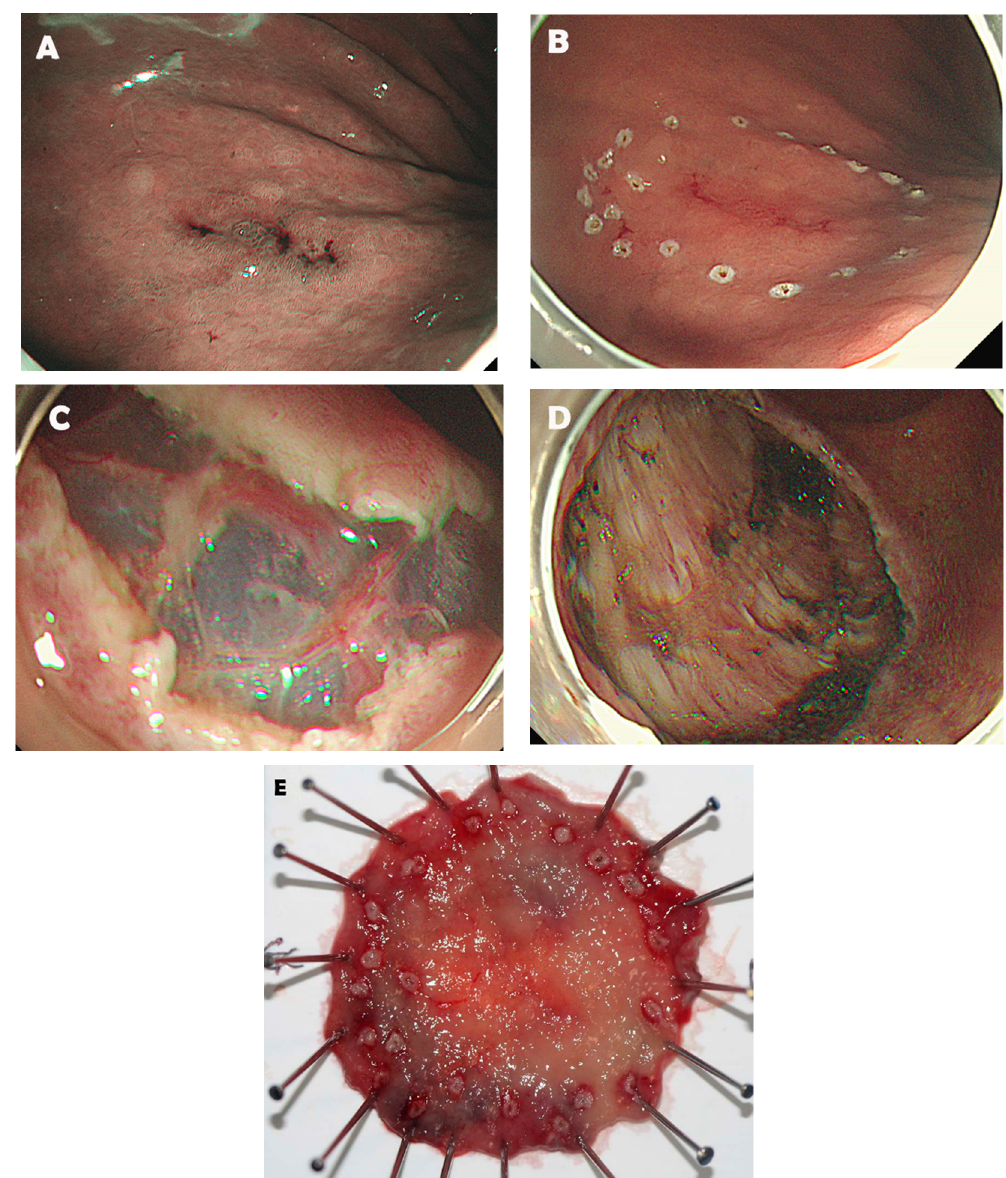
Figure 1. The procedure of endoscopic submucosal dissection (ESD). 1.8 × 1.7 sized type IIb early gastric cancer located at the greater curvature side of the antrum ( A ). Marking was made circumferentially at approximately 5 mm lateral to the margin of the lesion ( B ). The submucosal layer just beneath the lesion was dissected using an electrosurgical knife ( C ). The artificial ulcer was seen after complete resection of the lesion ( D ). The resected specimen was on a plate with a central early gastric cancer ( E ).